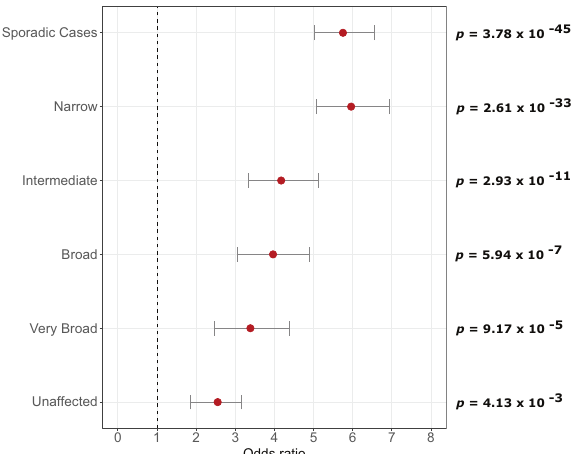
Fig. 2 Comparison of PRS between the ISHDSF diagnostic categories and sporadic cases, versus population controls. All analyses follow the hypothesis that ISHDSF members and sporadic cases have a higher PRS compared to population controls. All PRS have been normalized using Z-score standardization prior to obtaining odds ratios. The plots show odds ratios (OR, fi lled circles) with 95% con fi dence intervals (CI) for each category compared to population controls. X axis represents the odds ratios. Left side of Y axis represents each of the categories used for comparison versus population controls. Right side of the Y axis represents the p- values after multiple testing